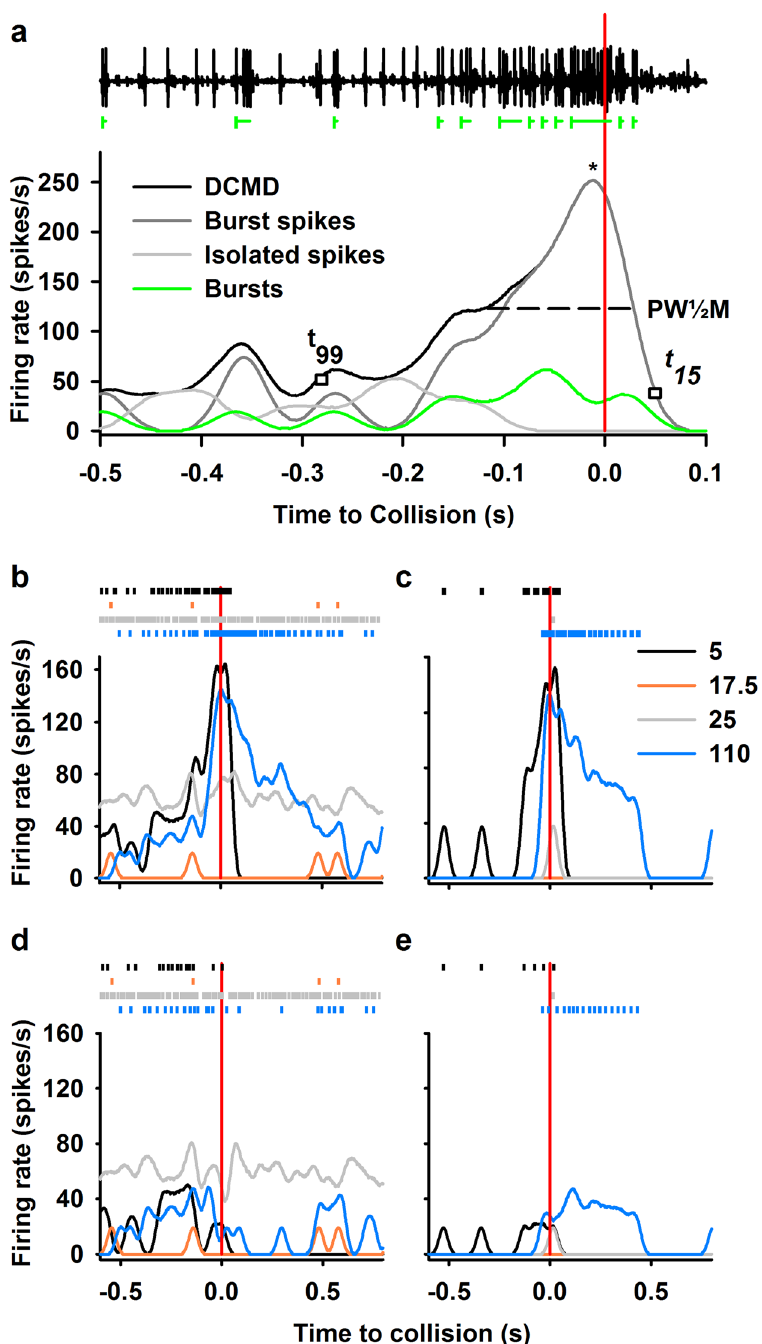
Figure 4. Rasters and peristimulus time histograms (PSTHs) constructed from DCMD responses to looming stimuli. ( a ) Raw continuous data from an extracellular recording of the left ventral nerve cord during presentation with the image of a 7 cm looming disk to the right eye (top). DCMD spikes were easily differentiated by their large amplitude. The projected time of collision (TOC) is marked with a vertical red line. Bursts, which comprise a minimum of two spikes occurring within 8 ms of each other, are highlighted with a vertical green line to signal the start, and horizontal lines to show the duration. PSTHs show the firing rates of the full DCMD response, spikes within bursts only, isolated spikes only, and bursts, smoothed with a 50 ms Gaussian filter. PSTHs response profile parameters included: peak firing rate ( f p ) and the time of the peak relative to TOC (pt), denoted by an asterisk; peak width at half maximum (PW½M), rise phase, from the last time the histogram crosses the 99% confidence interval with a positive slope (t99) to the peak, and decay phase from the peak until it had decreased to 15% (t15). ( b – e ) Show rasters (top) and PSTHs (bottom) at four time points after injection with 100 ng/g IMD, 5, 17.5, 25, and 110 minutes. These panels are separated by rate type: full DCMD ( b ), burst spikes only ( c ), isolated spikes only ( d ), and bursts ( e